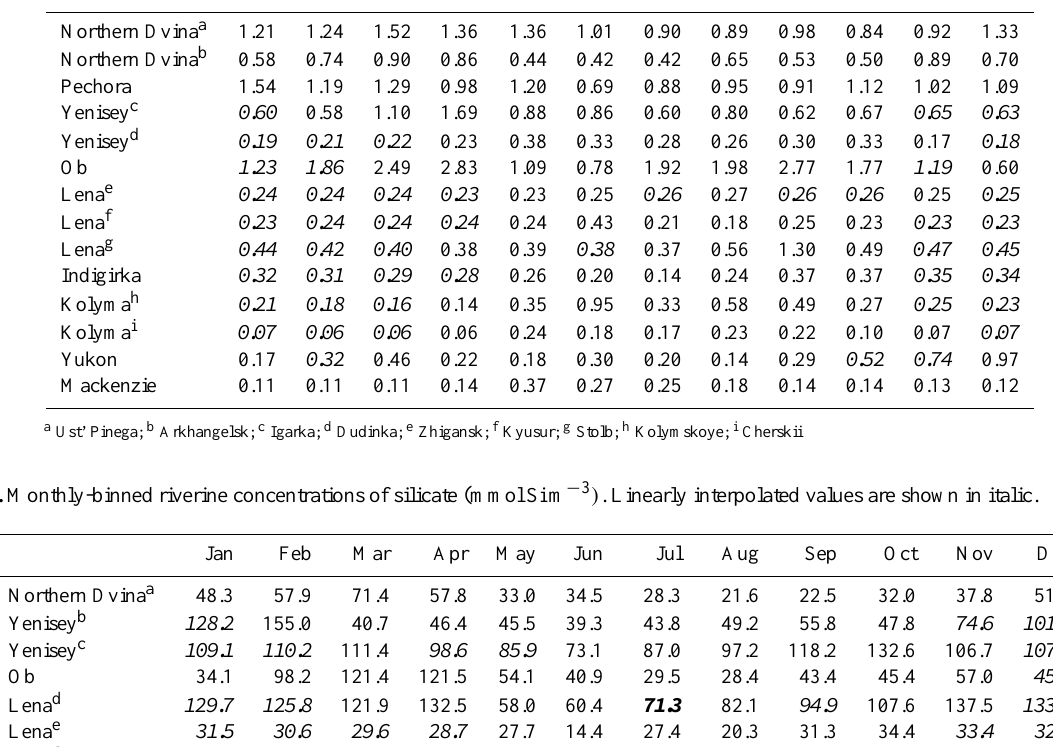
Table A2. Monthly-binned riverine concentrations of SRP (mmolPm − 3 ) . Linearly interpolated values are shown in italic. Jan